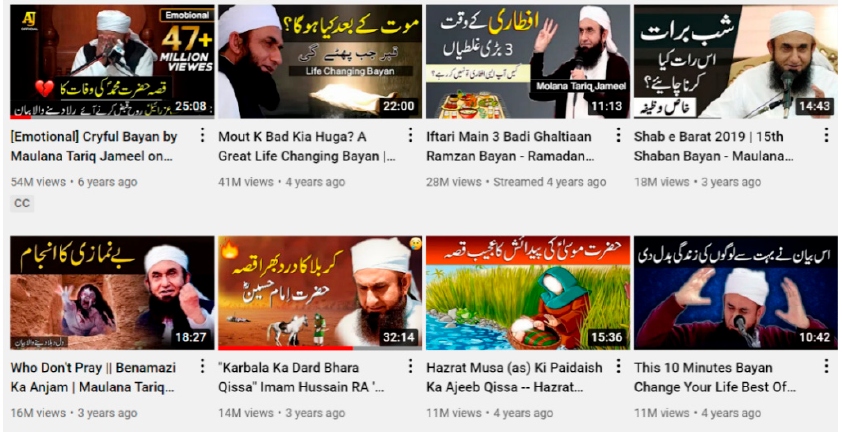
Figure 10. Maulana Tariq Jamil has a YouTube following which few other religious scholars can hope to match.